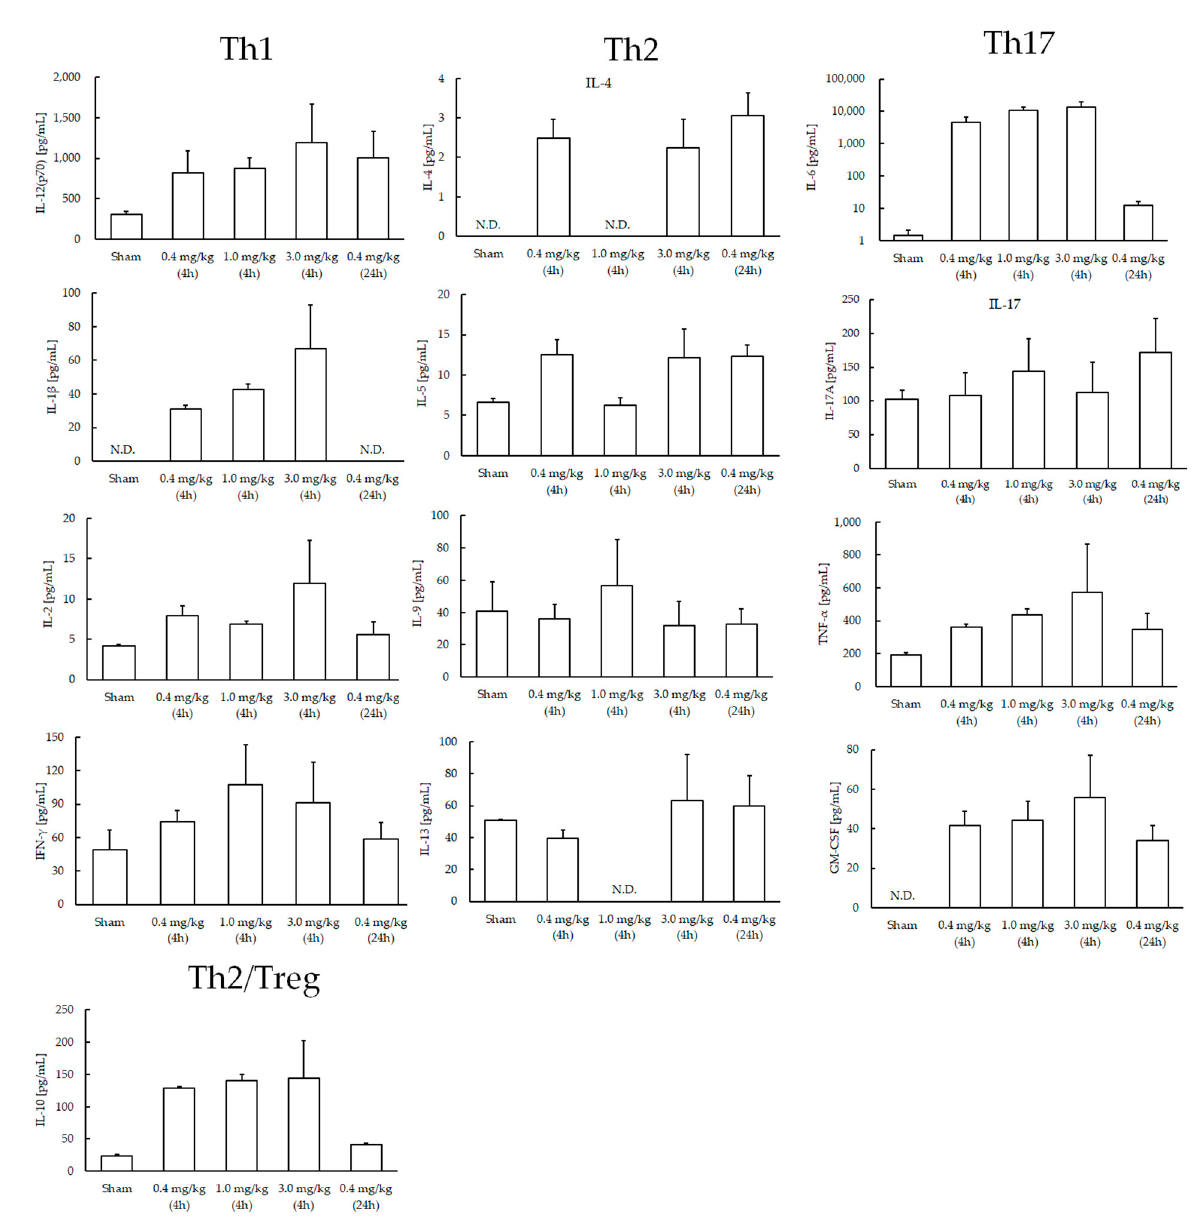
Figure A1. Changes in the cytokines in the serum of lipopolysaccharide (LPS)-induced differentiation-inducing and Th1-, Th17-, and Th2/Treg-prone cytokines. The results are presented as the mean ± SEM. N = 2–3; sham, mouse group without any treatment; 4 or 24 h after 0.4 mg/kg body weight of LPS; 4 h after 1.0 mg/kg body weight of LPS; 4 h after 3.0 mg/kg body weight of LPS; IL, interleukin; TNF, tumor necrosis factor; GM-CSF, granulocyte–macrophage colony-stimulating factor; IFN, interferon; N.D., not detected.